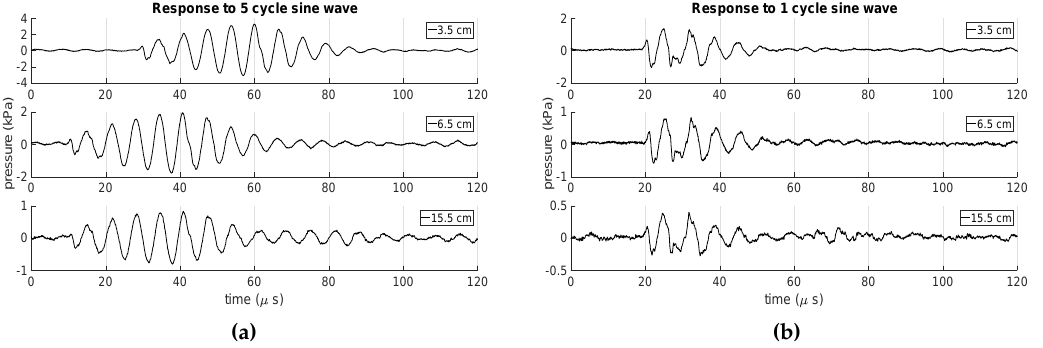
Figure 20. The measured time response of the resonating shell transducer to a 7 V p-p burst sinus signal with 5 cycles ( a ) and 1 cycle ( b ) at different distances